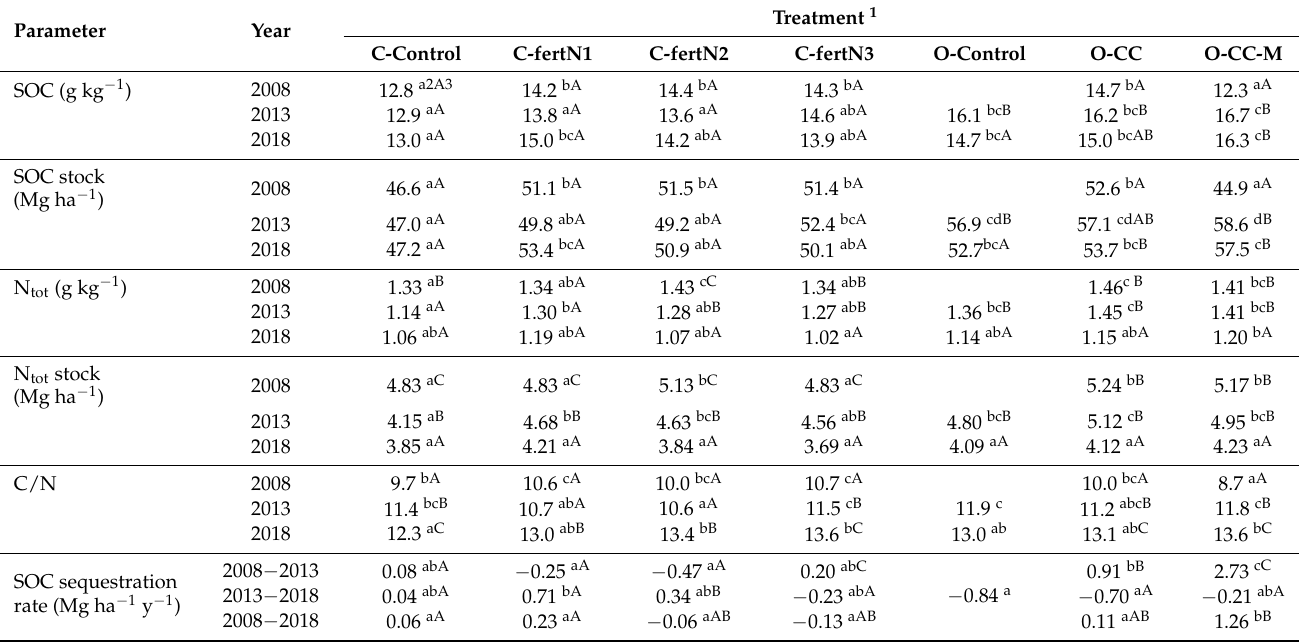
Table 3. Soil organic carbon (SOC), total nitrogen (N tot ) concentrations and stocks, C/N ratio, and SOC sequestration rates depending on